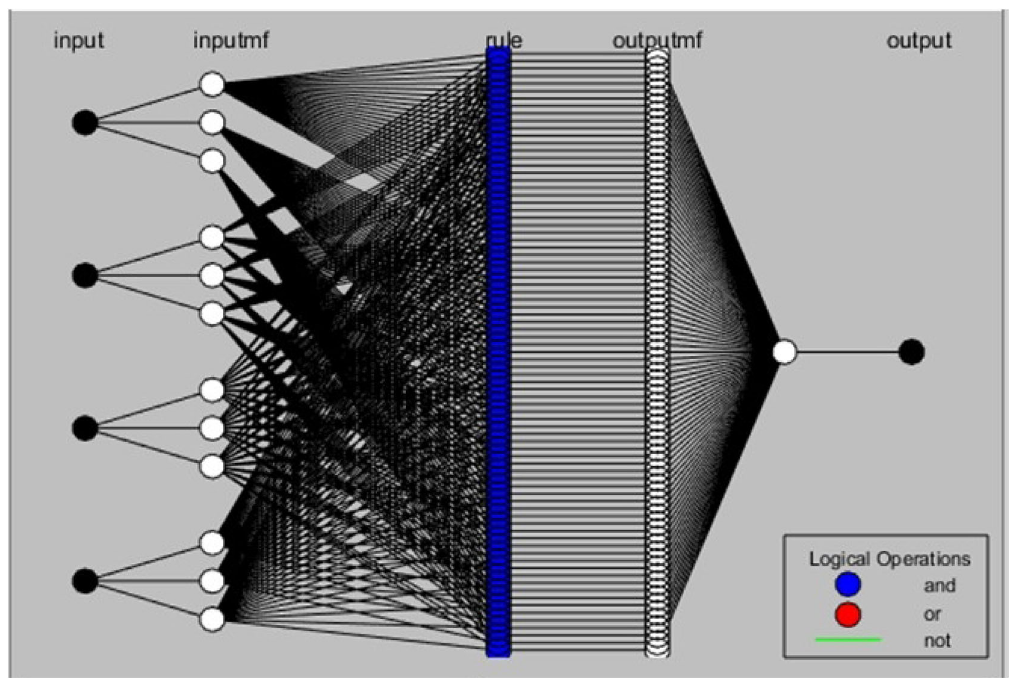
Fig. 7 ANFIS model